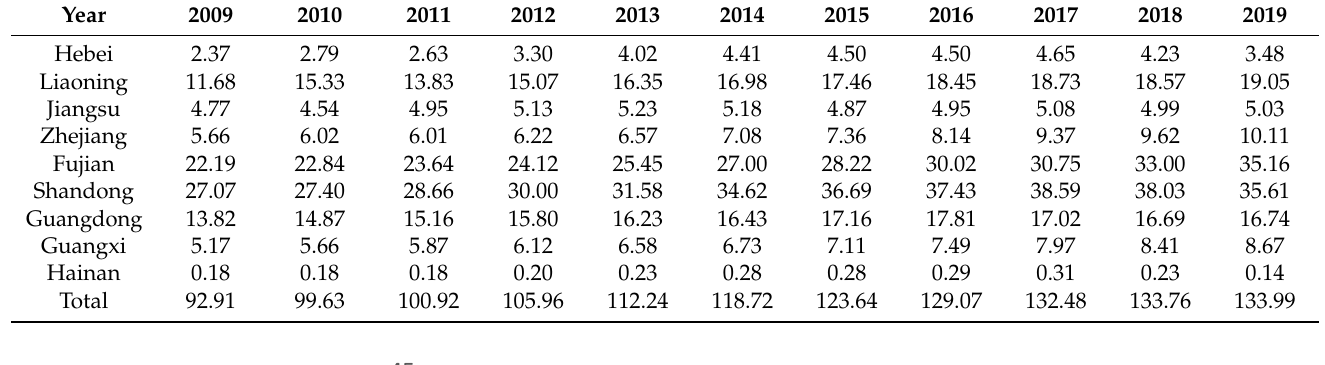
Table 6. Carbon sinks of marine fisheries in nine coastal provinces from 2009 to 2019 year (10,000 tons).